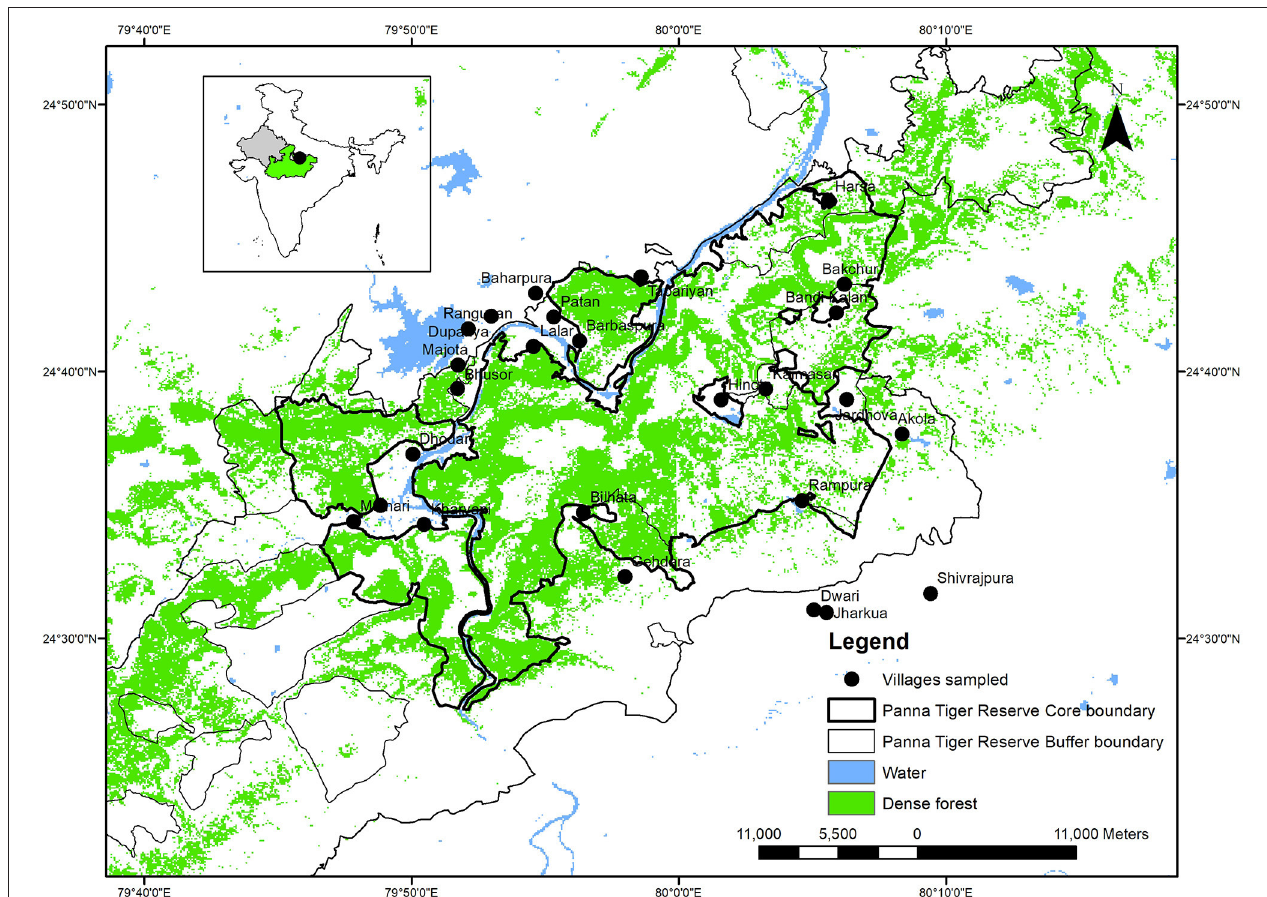
FIGURE 2 | Map showing sampled villages in Panna Tiger